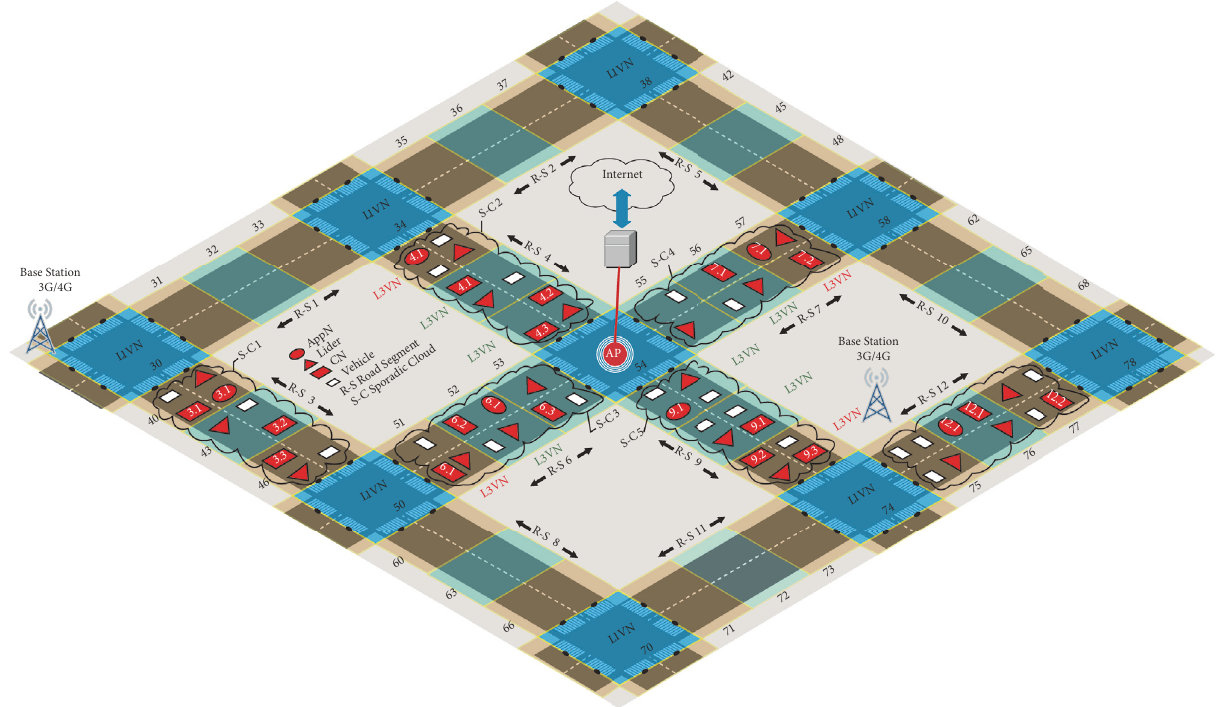
Figure 3: Possible connectivity options of AppNs in the NaaS model supported by our S-CMA